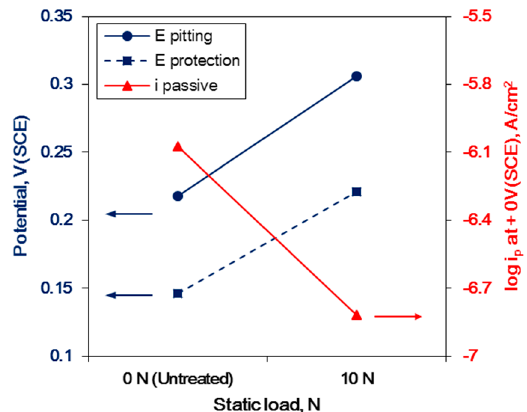
Figure 13. The effect of the static load under the critical UNSM condition on the corrosion factors of Alloy 600.